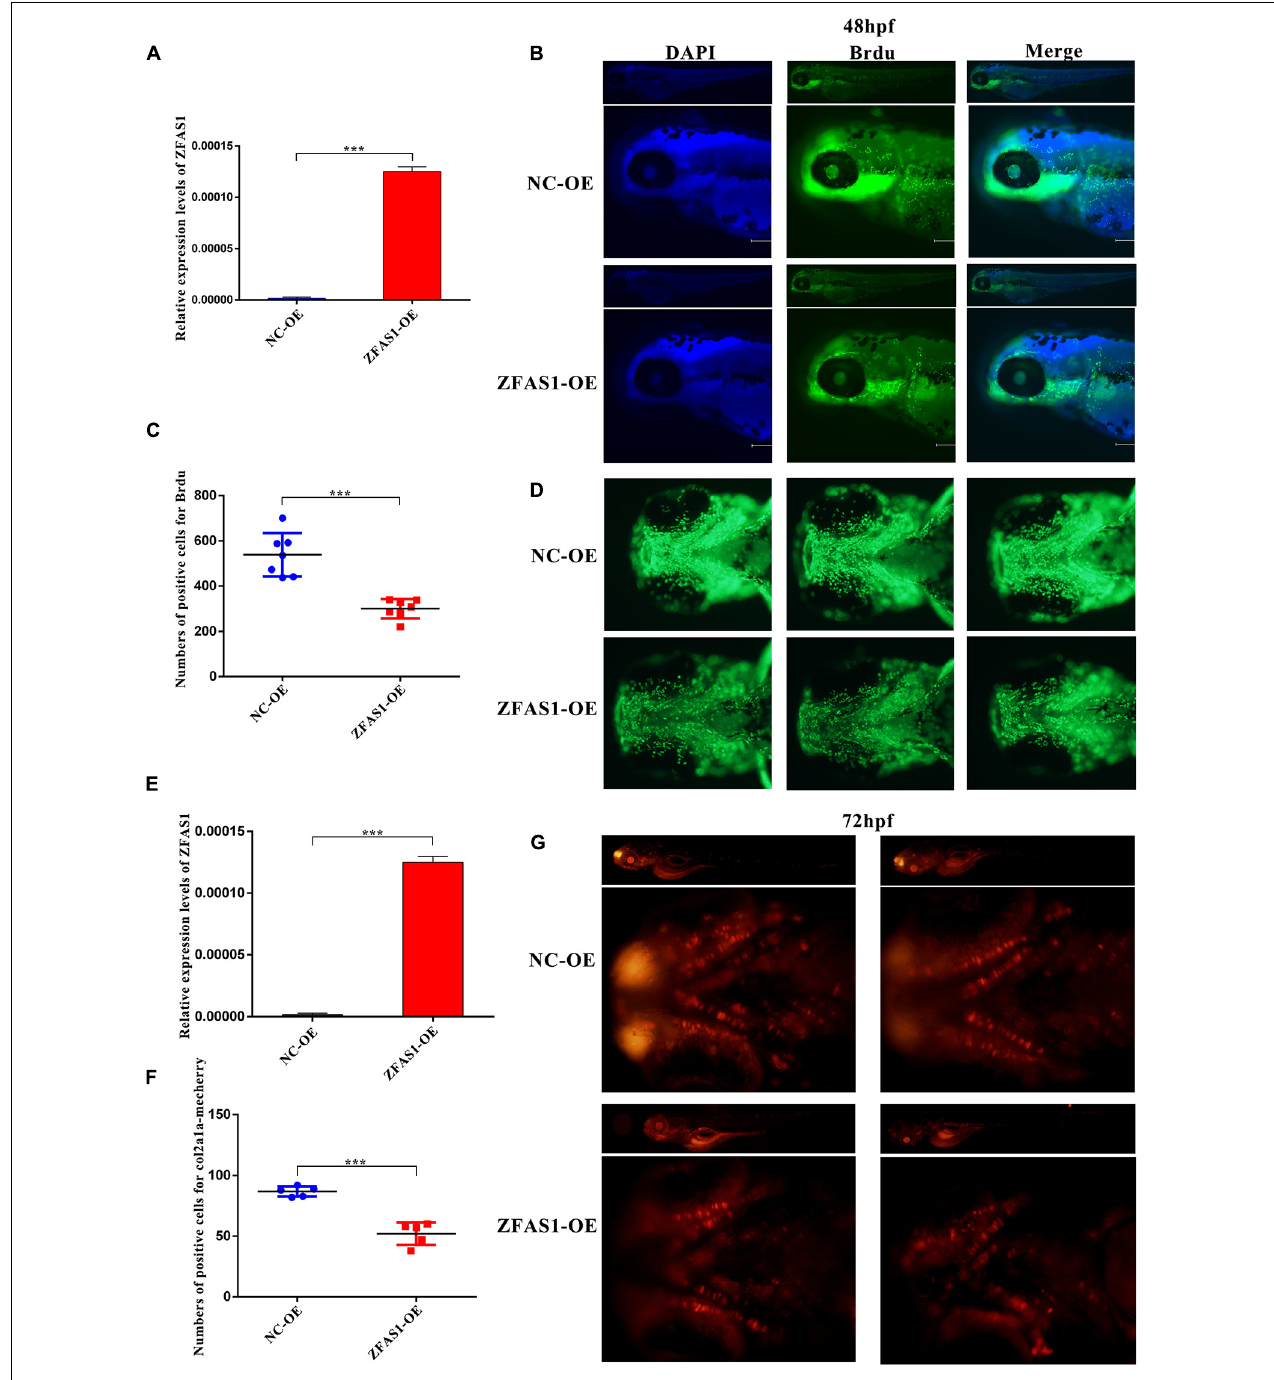
FIGURE 4 | ZFAS1 overexpression in zebrafish embryos significantly decreased cell proliferation and numbers of chondrocyte in the ethmoid plate. (A) The efficiency of overexpressing ZFAS1 in wild-type zebrafish embryos by microinjection using the qPCR assay. (B) The side view of bromodeoxyuridine (BrdU)-labeling cells in zebrafish at 48 hpf detected by fluorescence microscope. Left, blue fluorescence for DAPI; middle, green fluorescence for BrdU; right, the merged image. (C) The statistical results of BrdU-positive cells in the zebrafish ethmoid plate. (D) The ventral view of BrdU-positive cells in the zebrafish ethmoid plate. (E) The efficiency of overexpressing ZFAS1 in Tg(col2a1a-mcherry) zebrafish embryos by microinjection using the qPCR assay. (F) The statistical results of col2a1a-mcherry-positive cells in the zebrafish ethmoid plate. (G) The ventral view of col2a1a-mcherry-positive cells in the zebrafish ethmoid plate at 72 hpf. Red fluorescence, col2a1a-mcherry. Values are mean ± SEM, n = 3, *** P <